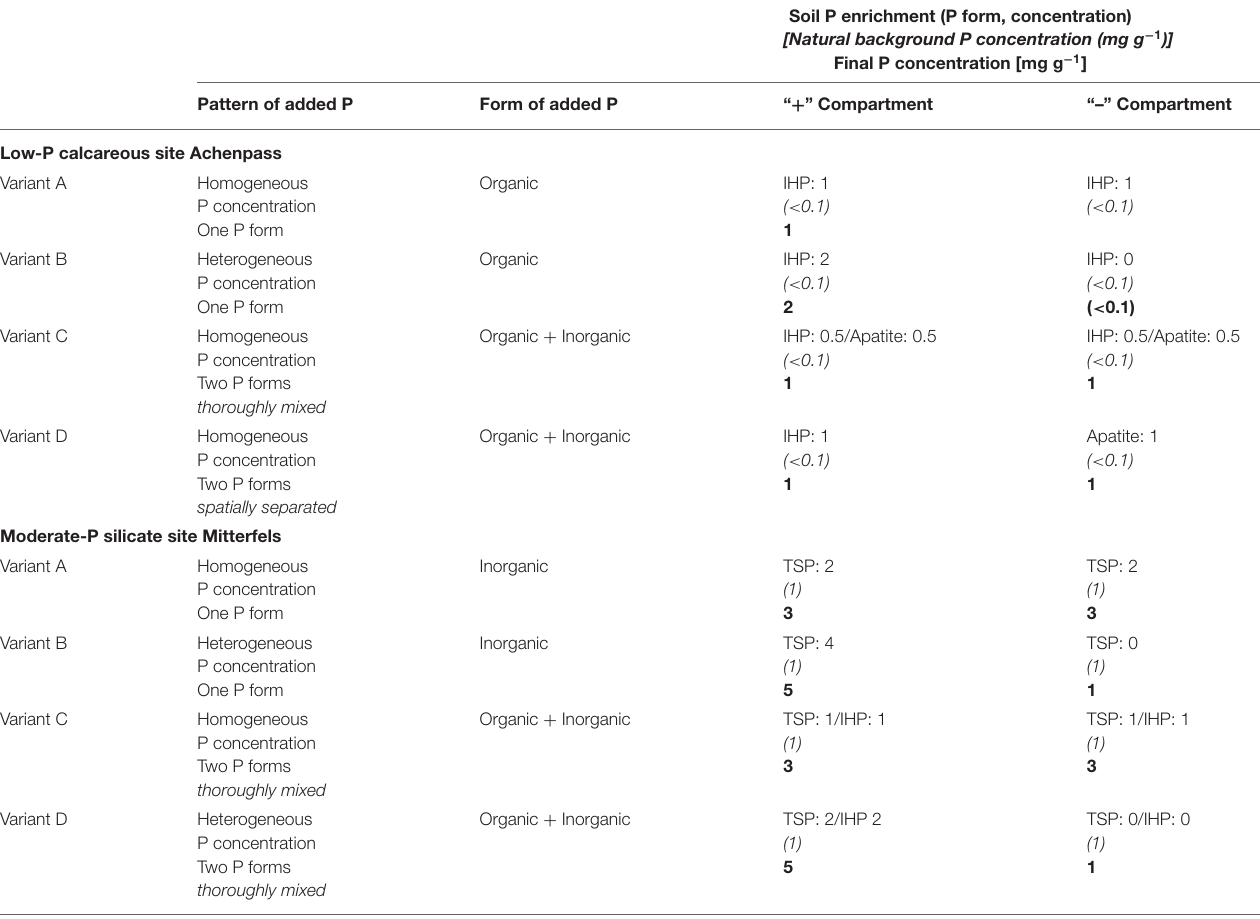
TABLE 1 | Soil P enrichment patterns of “ + ” and “–” Compartments in different variants of the P heterogeneity experiments Achenpass and Mitterfels .